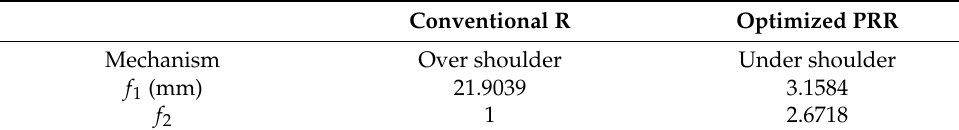
Table 2. Optimal objective function values.